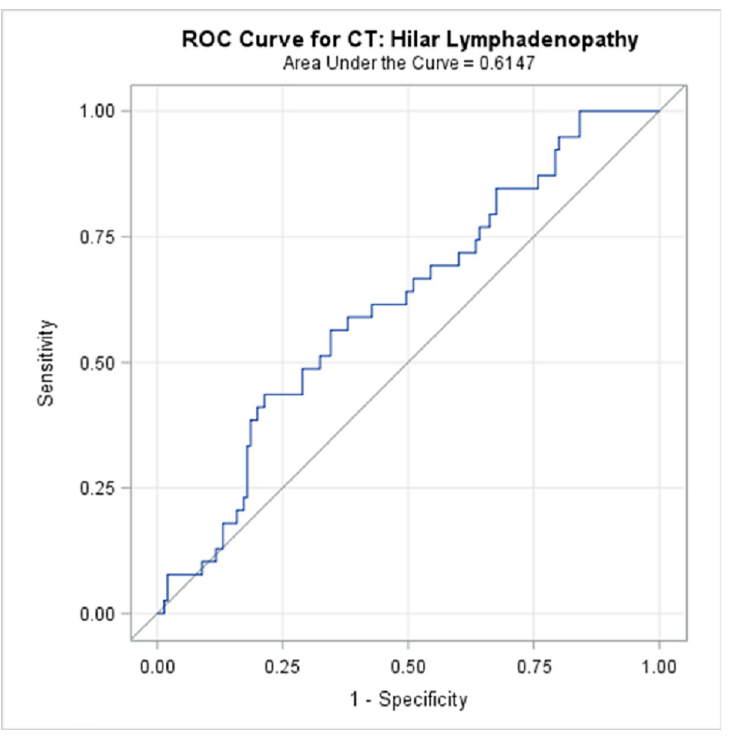
Fig 6. ROC Curve for CT: Hilar Lymphadenopathy.